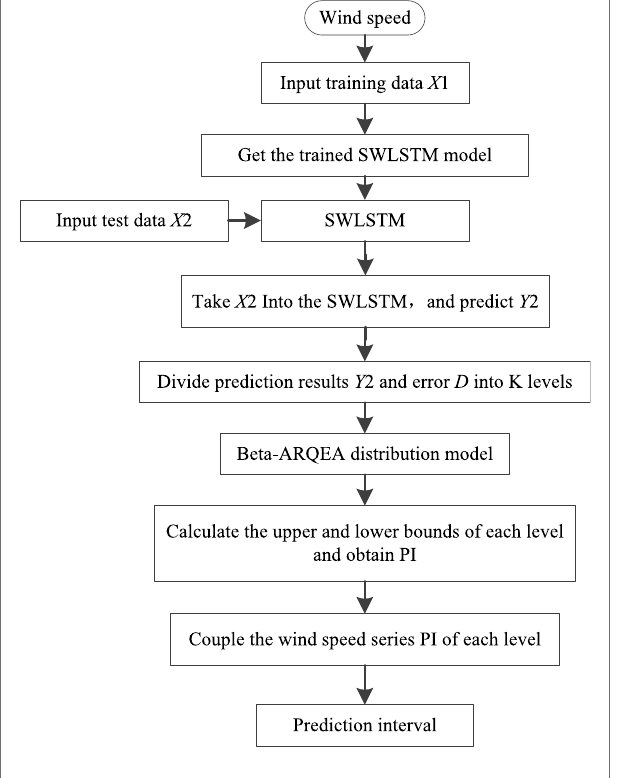
FIGURE 2 | Wind speed PI implementation based on beta – ARQEA – SWLSTM.